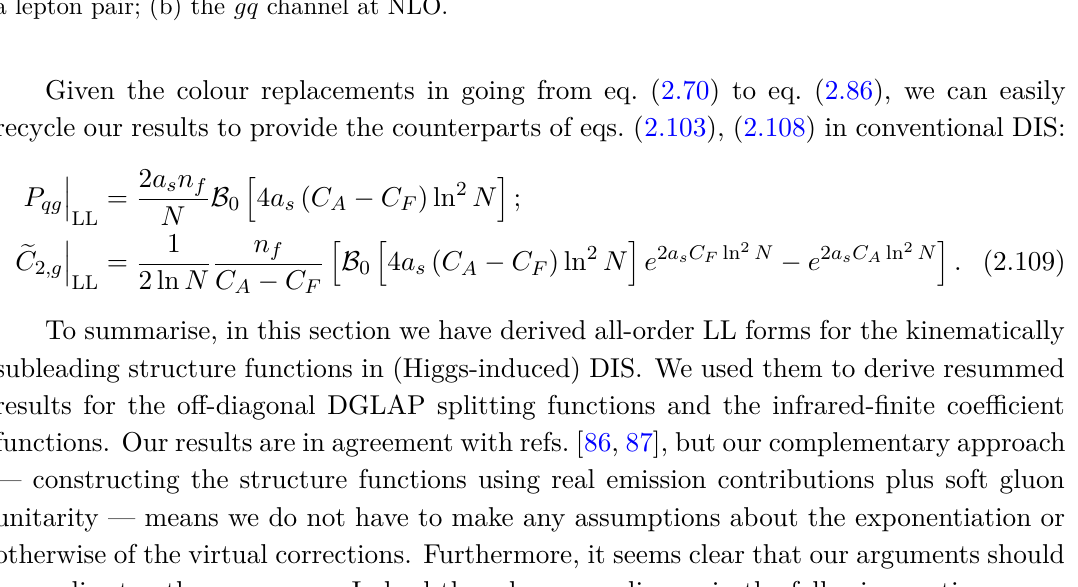
Figure 5. (a) LO squared amplitude for the DY production of an off-shell photon, with decay to a lepton pair; (b) the g ¯ q channel at